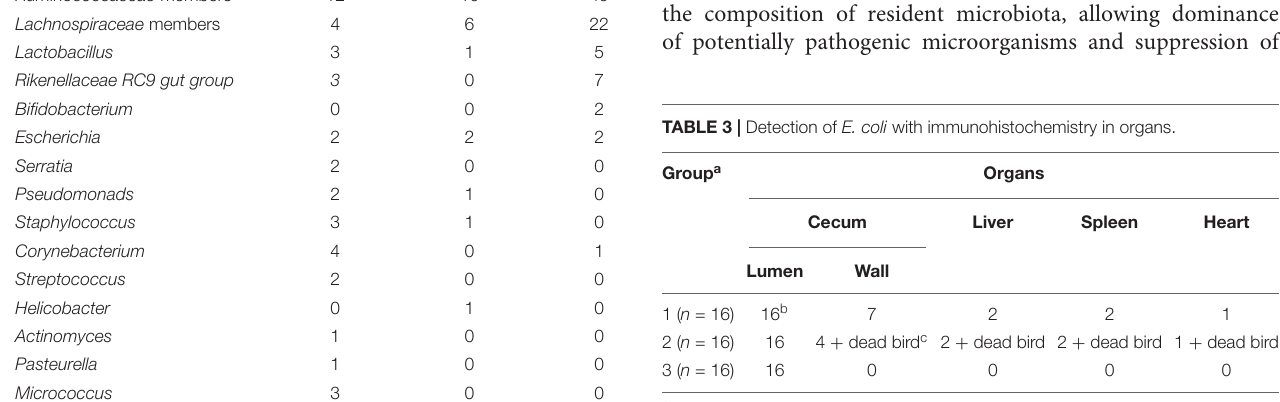
TABLE 2 | List of 15 most important commensal and pathogenic bacterial genera and their ASVs shared between cecum and blood. Genera